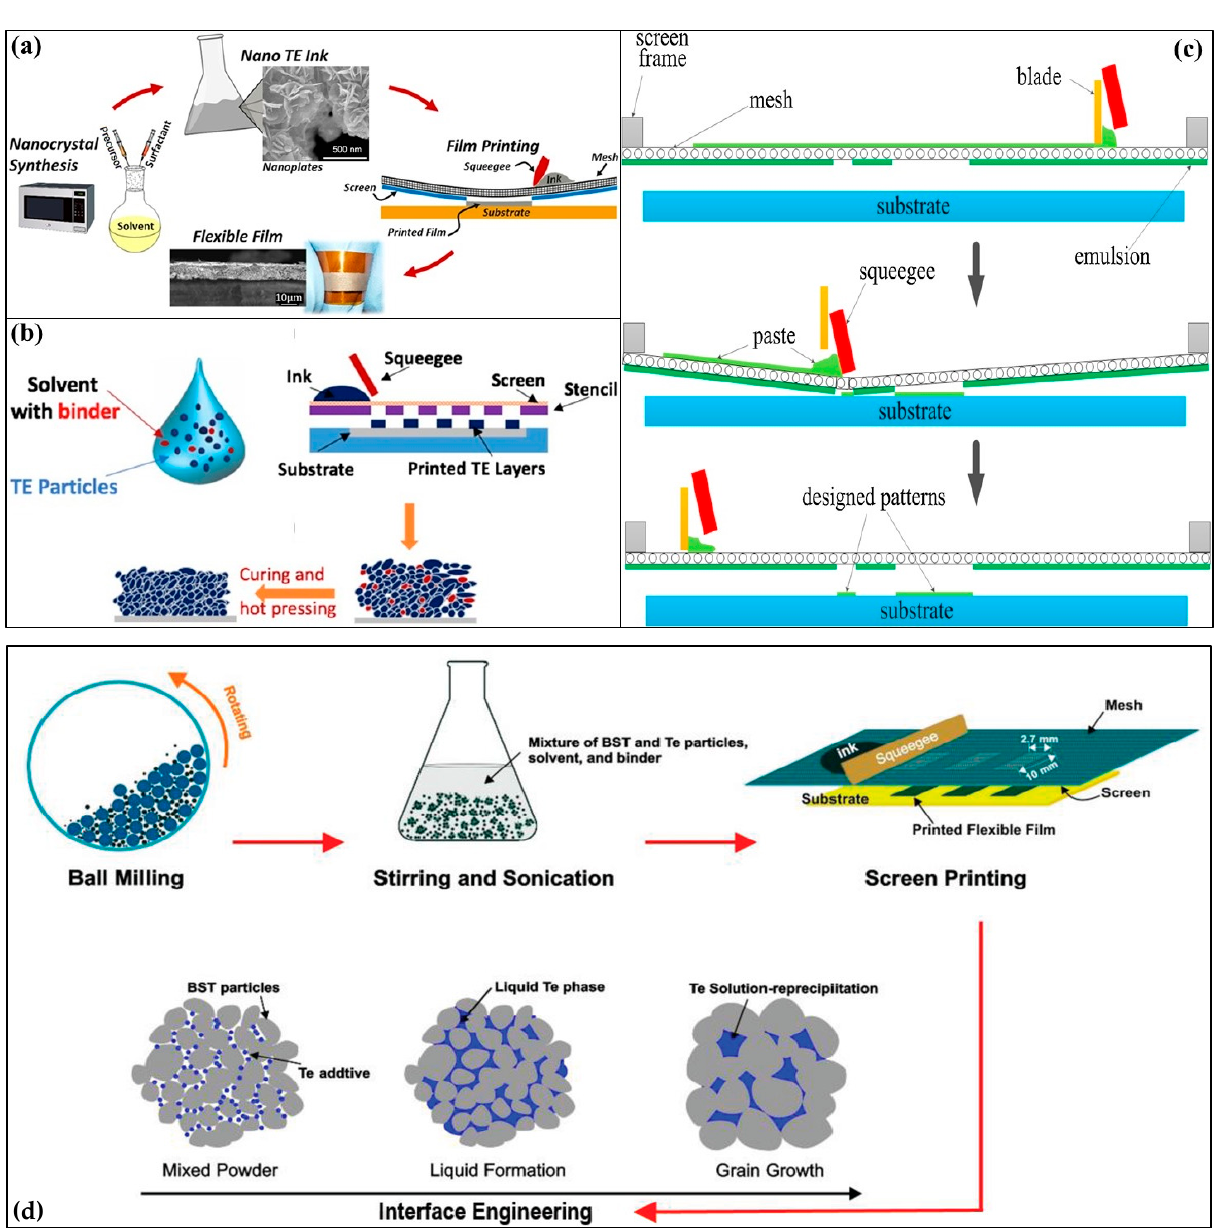
Figure 8. ( a ) Schematic illustration of the overall flexible n-type Bi 2 Te 2.8 Se 0.2 TE films fabrication process from nanocrystal synthesis to sintered flexible films, including nano TE ink processing and screen printing on a flexible substrate. Reproduced with permission from [86]. Copyright Scientific reports, 2016, ( b ) Schematic illustration of the fabrication of flexible TE films with p-type Bi 0.5 Sb 1.5 Te 3 and n-type Bi 2 Te 2.7 Se 0.3 . The printable ink, screen-printed TE layer, and hot-pressed layer (after screen printing) can also be seen. Reproduced with permission from [88]. Copyright Scientific reports, 2017, ( c ) Schematic illustration of pattern deposition for screen printed fabrication of flexible TE films with p-type Sb 2 Te 3 powders and n-type Bi 1.8 Te 3.2 powders. Reproduced with permission from [87]. Copyright Elsevier, 2016, ( d ) Overall fabrication of